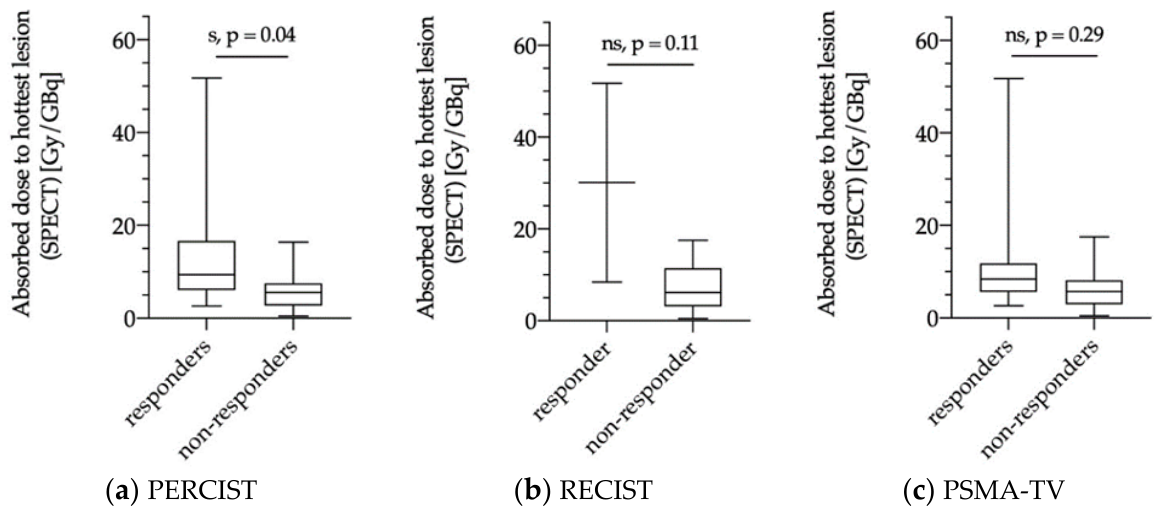
Figure 5. Mean absorbed tumor dose for averaged multiple lesions (“mean dose” in Gy/GBq) stratified according to re- sponders and non-responders using modified PERCIST criteria ( a ), RECIST 1.1 criteria ( b ), and PSMA-TV ( n = 21) ( c ) evaluated. s = significant, ns = not significant.